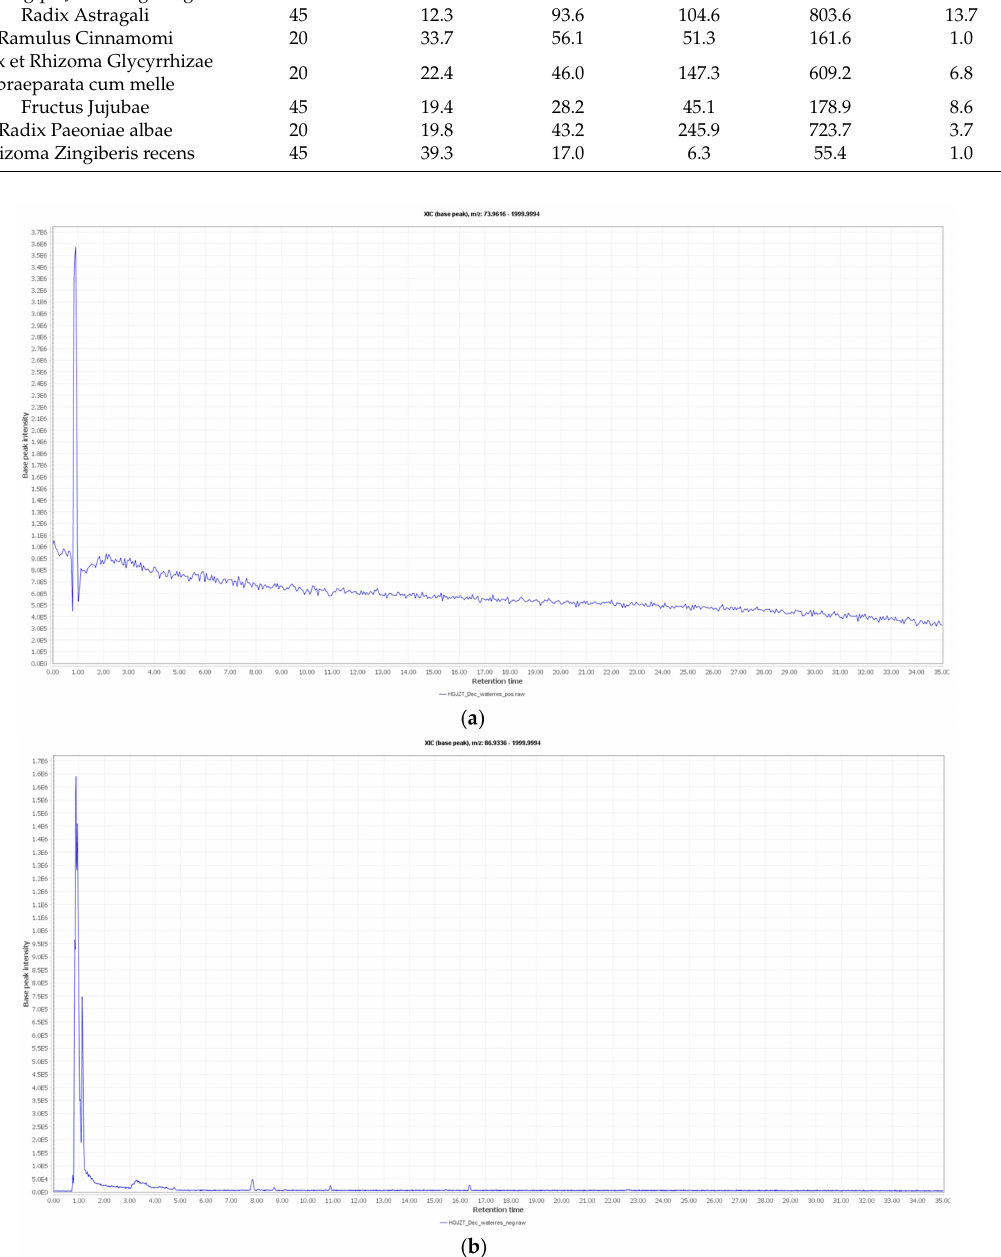
Figure A2. UHPLC-HRMS chromatograms of HQJZT water residue sample in ESI ( + ) mode ( a ) and ESI ( − ) mode ( b ); The main peak at 0.86 min was identified as sucrose. Analysis was performed